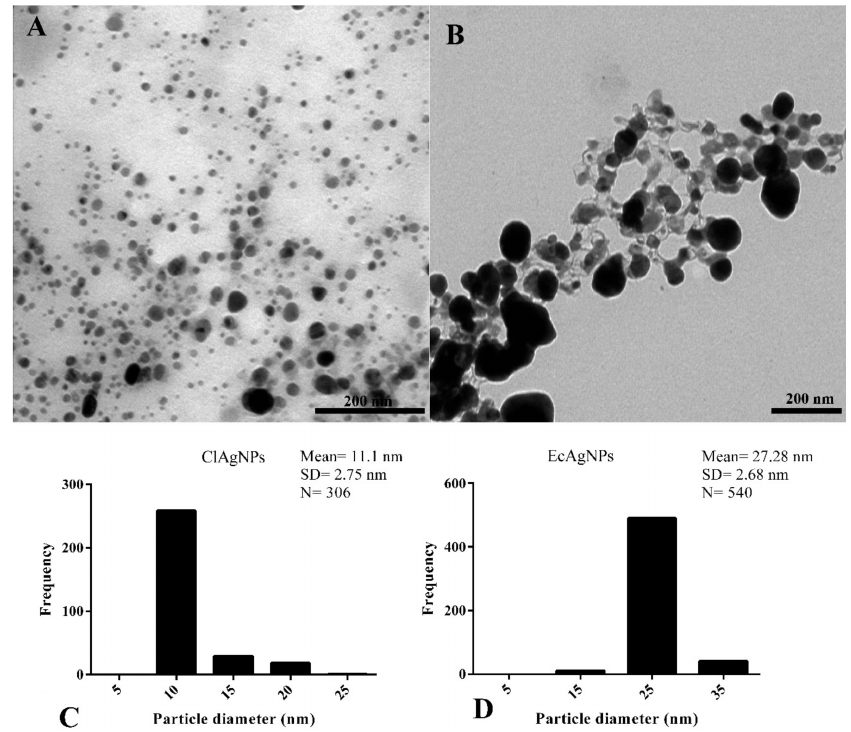
Figure 3. Morphological analysis by TEM. ( A , C ) NPs derived from C. longa showed roughly spherical morphology and mean diameter of 11.1 nm. ( B , D ) EcAgNPs showed a highly-branched symmetry and dimension of 27.28 nm in